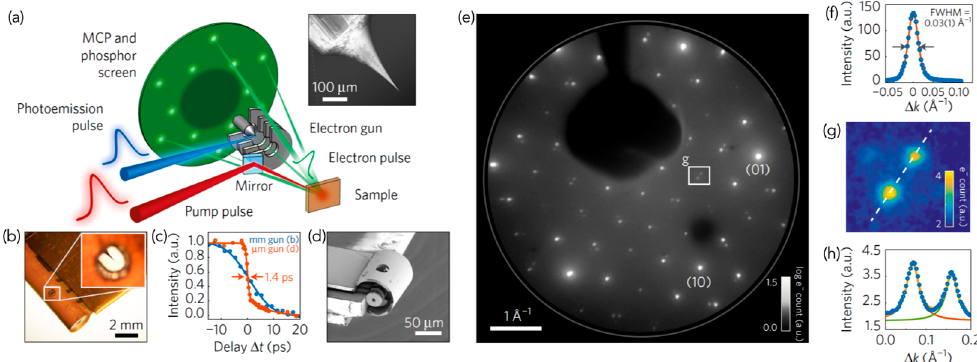
Figure 23. Ultrafast low-energy electron diffraction ( ULEED) setup and high-resolution diffraction pattern from 1T-TaS 2 . ( a ) Schematic of the experimental setup for ULEED. Inset: electron micrograph of an electrochemically etched tungsten tip used as a photoemitter. ( b ) mm-sized laser-driven electron gun. Inset: tungsten tip, visible through the hole for laser illumination. ( c ) Electron pulse durations of the mm-sized electron gun (16.4 ps at 100 eV) and the µ m-sized electron gun (1.4 ps at 50 eV). ( d ) µ m-sized electron gun prepared by nanofabrication. ( e ) LEED pattern of the near commensurate CDW room-temperature phase, recorded with pulsed 100-eV electrons from the mm-sized electron gun (logarithmic colour scale). A retarding voltage of − 20 V is applied at the detector front plate. ( f ) Line profile of the (1 1) diffraction peak, illustrating high transversal coherence of the source. The fitted spot width of 0.03 Å –1 (fwhm) corresponds to a transfer width of 21 nm. ( g ) Close-up of region marked in e, showing second-order CDW diffraction spots ( h ), Line profile of CDW diffraction spots shown in g, fitted with Lorentzian peak profiles. Figure adapted from Reference [262] with permission from Springer Nature.